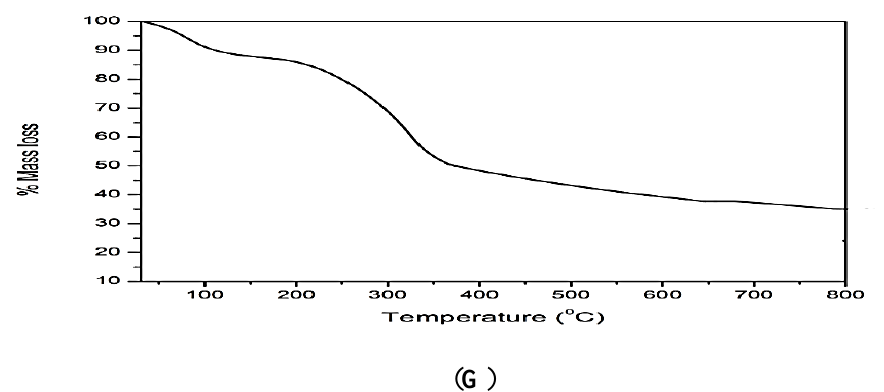
Figure 1. Characterization of biosorbent ( A ) FTIR spectra of CMPVL, ( B ) Zn loaded FTIR spectra of CMPVL, ( C , D ) SEM images of CMPVL and Zn loaded CMPVL, ( E ) EDX spectra of CMPVL, ( F ) EDX spectra of Zn loaded CMPVL, ( G ) TGA of CMPVL.